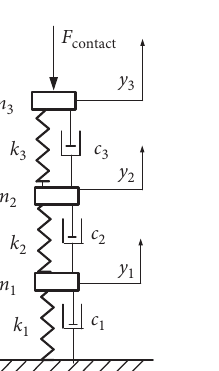
Figure 2: Typical linear spring-mass model of the